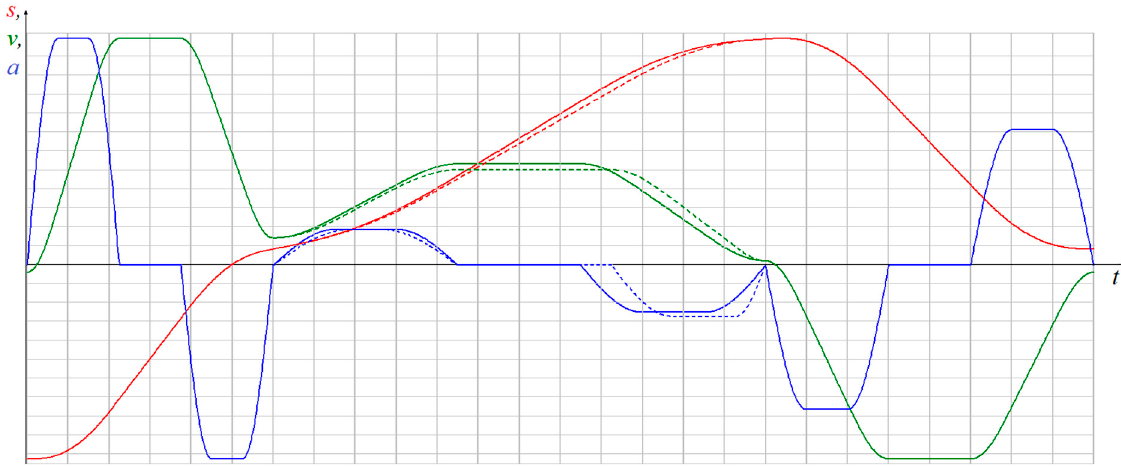
Figure 3. Modified seven traits acceleration motion law (blue curve), with imposed constraint values on displacement (red curve) and velocity (green curve).